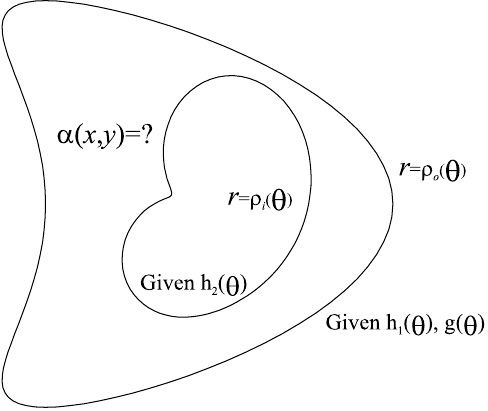
Figure 1. A schematic plot to show a doubly connected domain and for